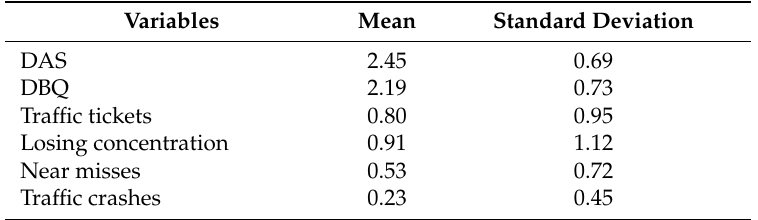
Table 1. Descriptive statistics for the DAS, DBQ, and crash-related conditions.